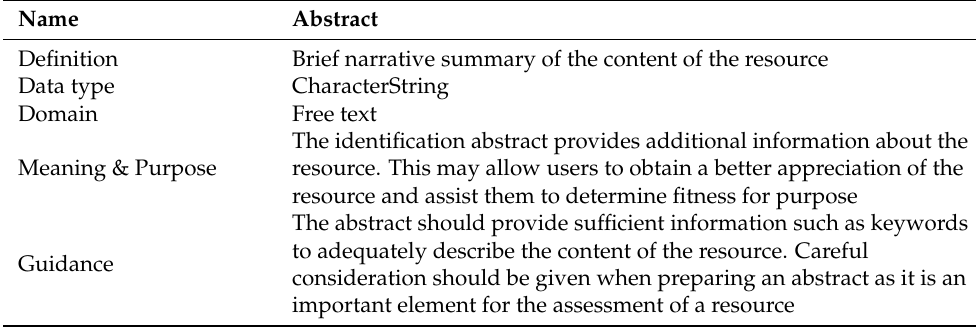
Table 17. Abstract description and guidance in the ANZLIC Metadata Profile Guidelines Version